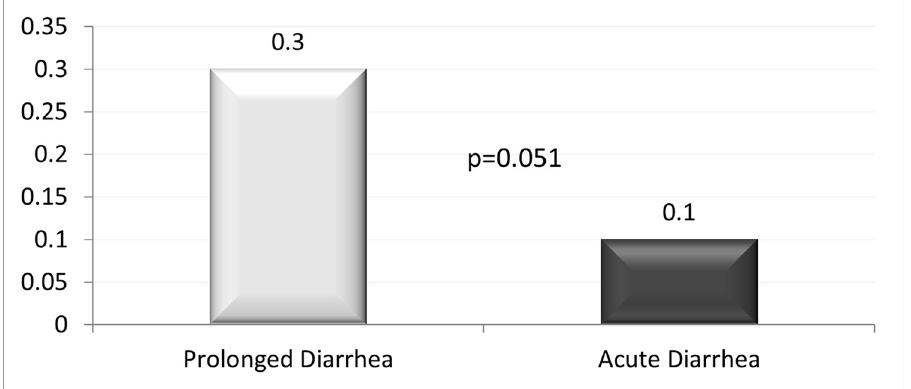
Fig 4. Case fatality rate (%) of children with prolonged diarrhea and acute diarrhea.